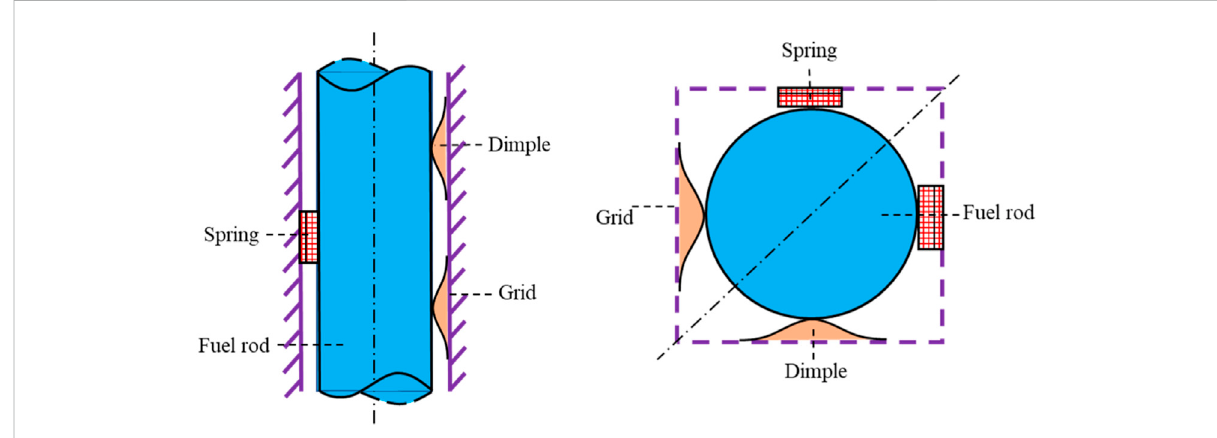
FIGURE 3 Schematic diagram of a fuel rod constrained by the grid.